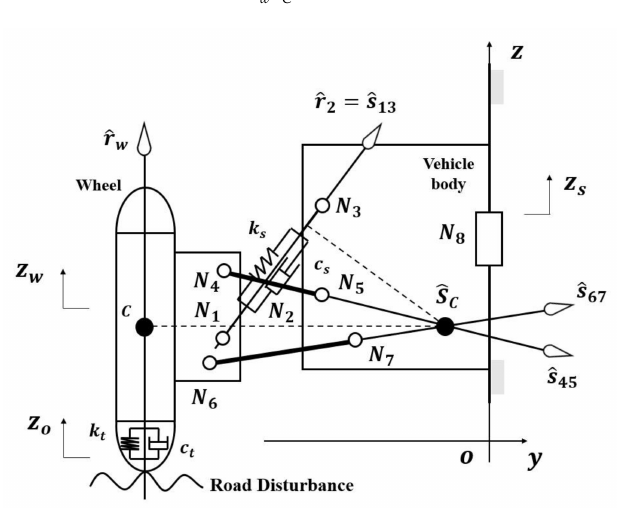
Figure 6. Wrenches acting on a quarter-vehicle